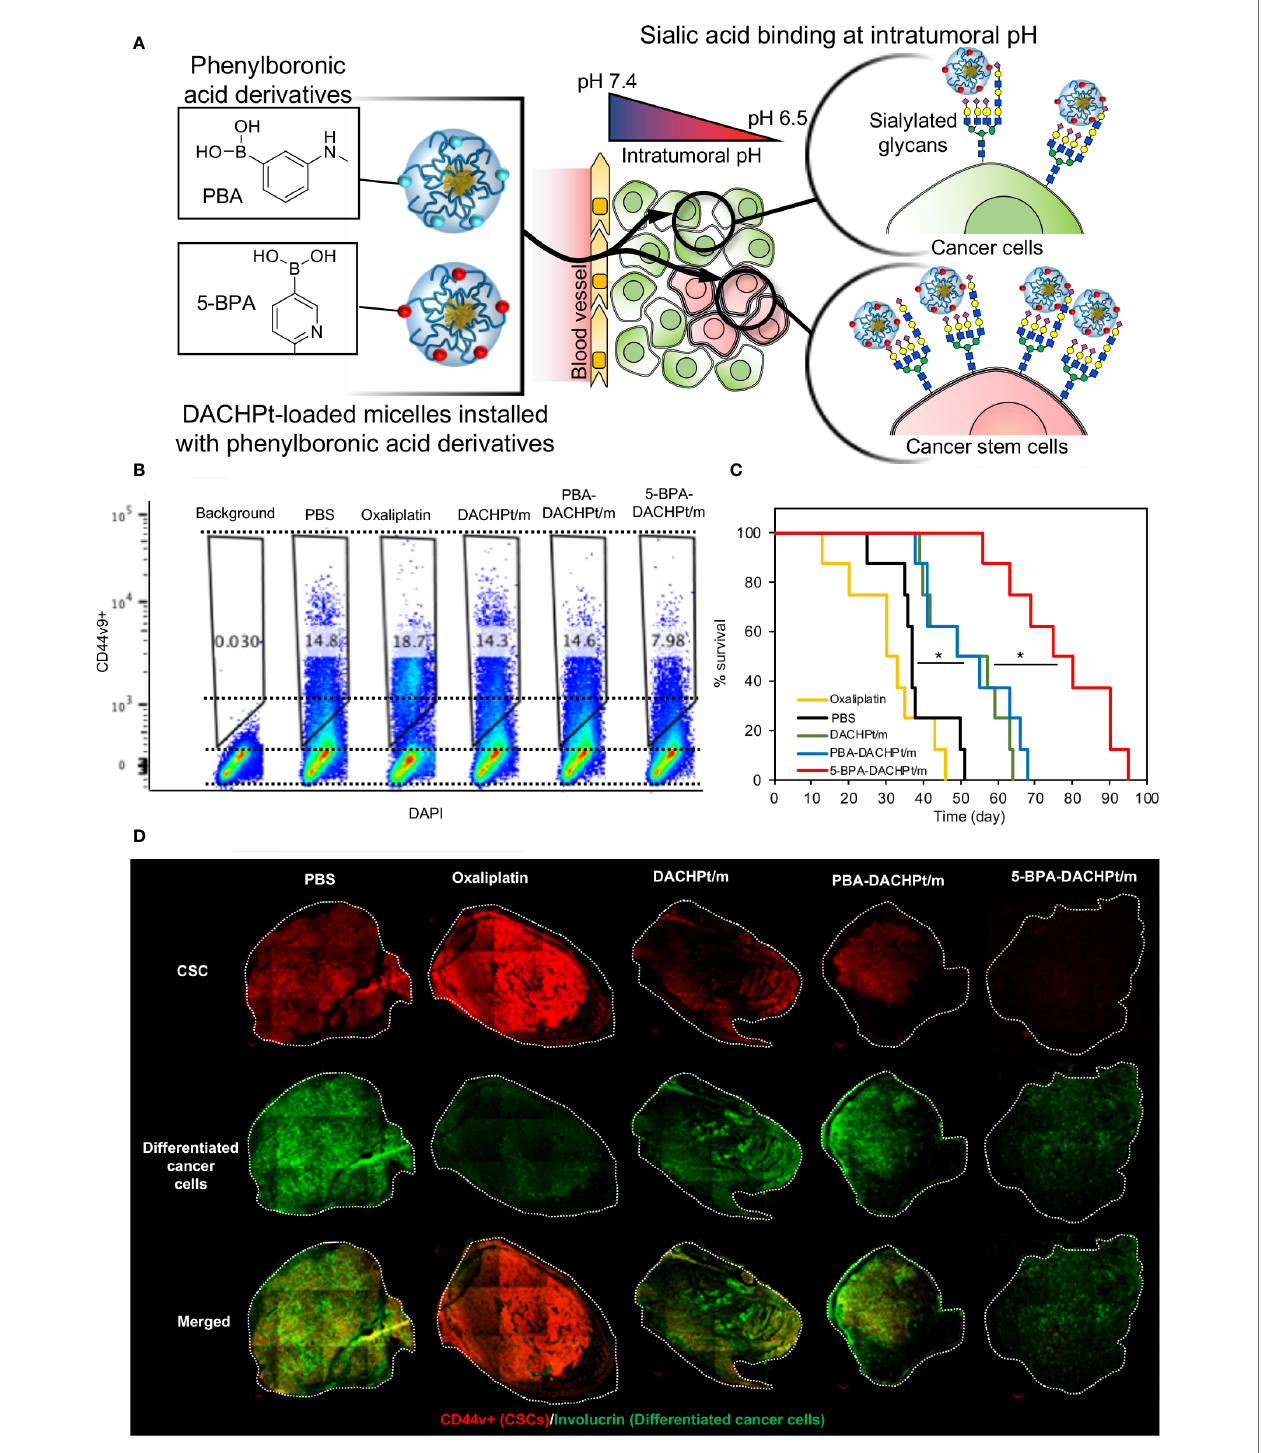
FIGURE 2 | Targeting sialylated epitopes on cancer cells by using pH-activated 5-boronopicolinic acid (5-BPA) as a ligand. (A) Design strategy and targeting of overexpressed SA in CSC using pH-sensitive 5-BPA installed polymeric micelles. (B) Reduction of CD44+ CSCs in head and neck cancer cells (HSC-2) in vitro . (C) Improved survival of animal treated with 5-BPA installed polymeric micelles (D) Signi fi cant reduction in CD44+ CSC population (red) after treatment with 5-BPA installed polymeric micelles. Adapted with permission from reference (88). Copyright 2020 American Chemical